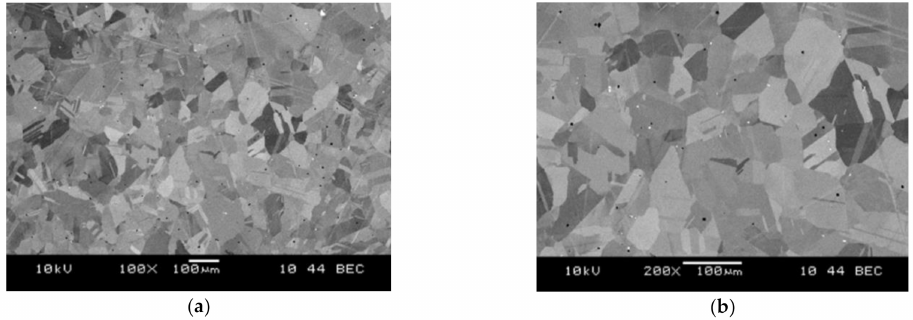
Figure 2. Microstructure of cast alloy at magnification 100 × ( a ) and 200 × ( b ).